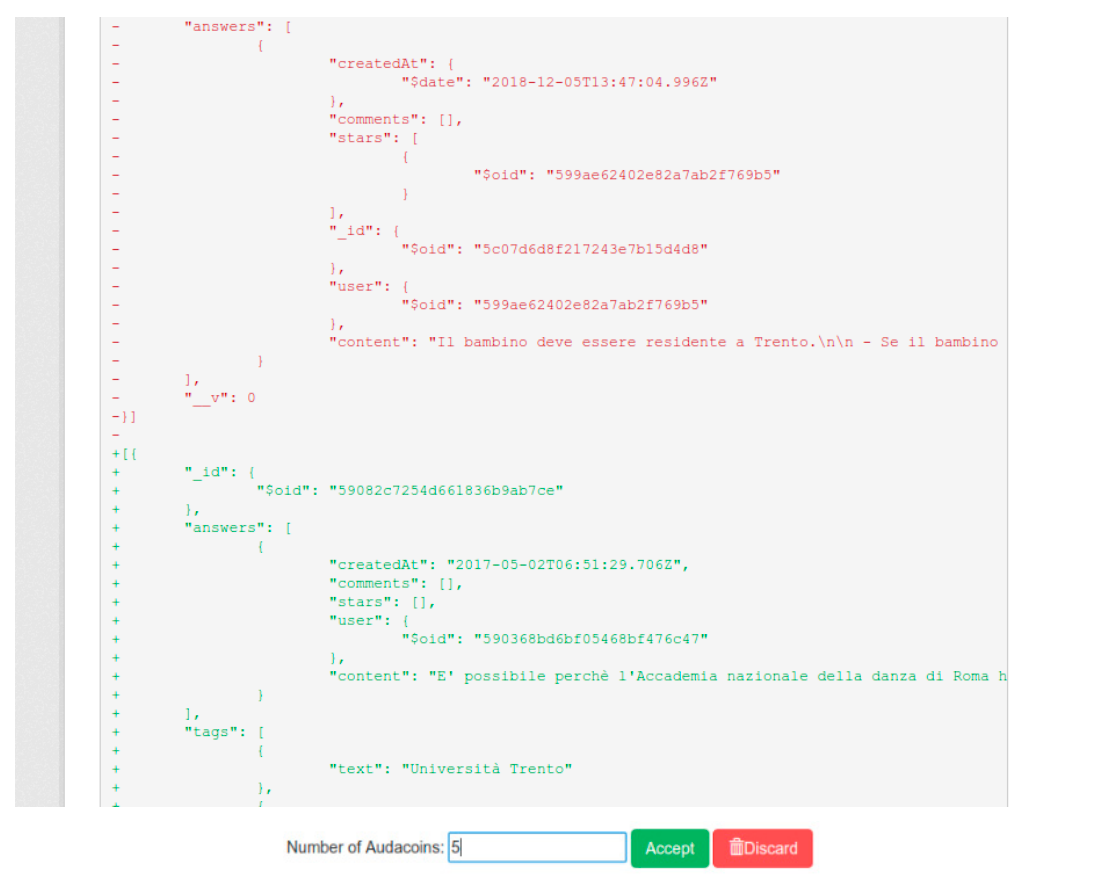
Figure 7. View seen by administrator to verify changes performed by user, where they have to accept or discard the change request and assign AudaCoins in case of